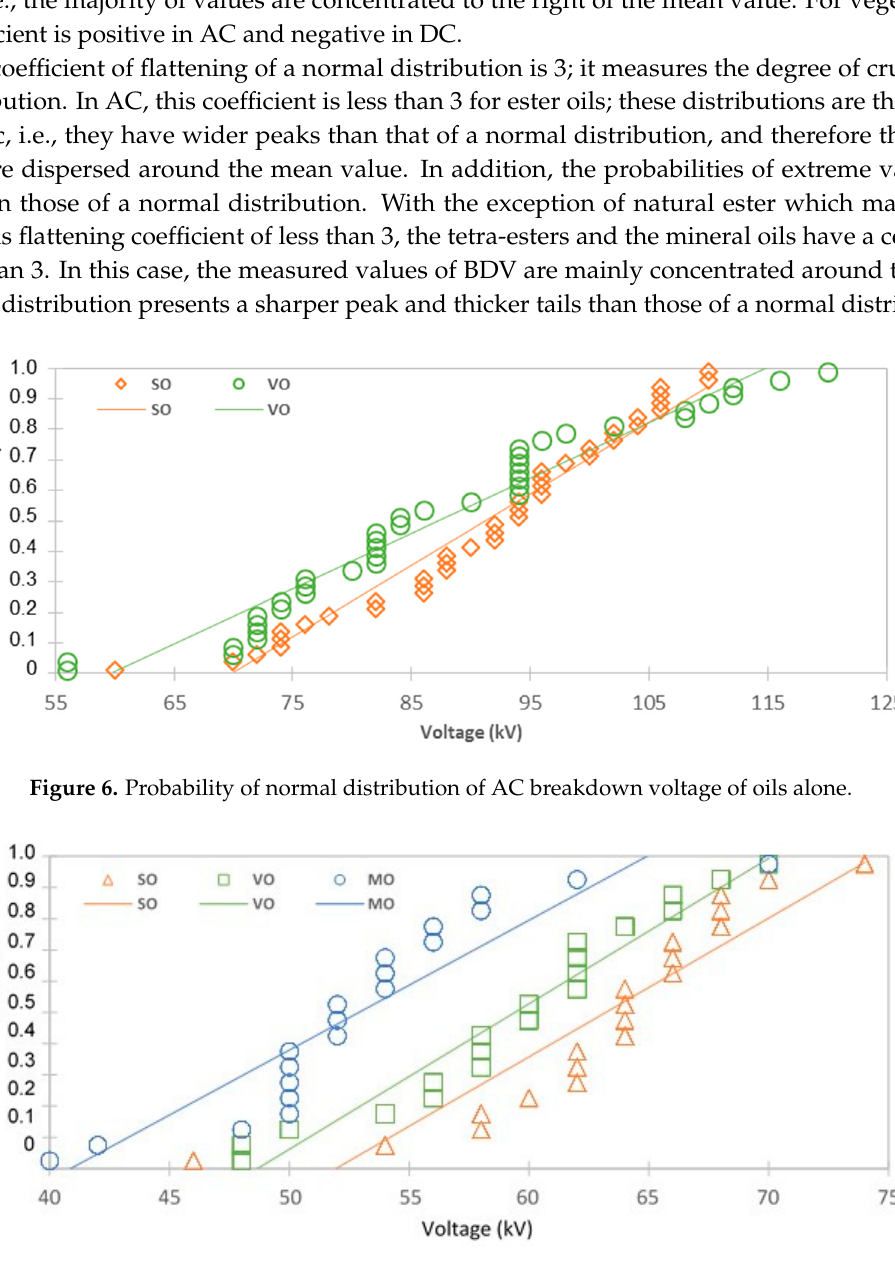
Figure 7. Probability of normal distribution of DC breakdown voltage of oils alone.